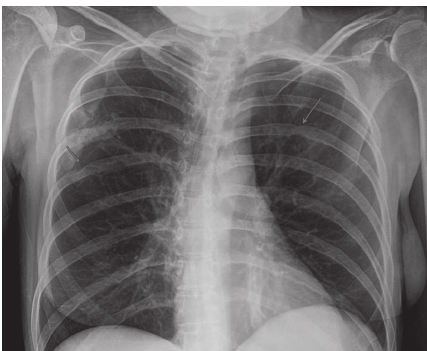
Figure 1: Chest radiograph demonstrating erosive changes of the fifth and sixth ribs.